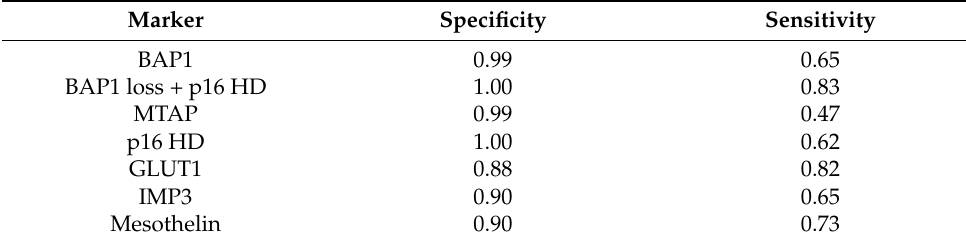
Table 1. Pooled specificity and sensitivity values of biomarkers.